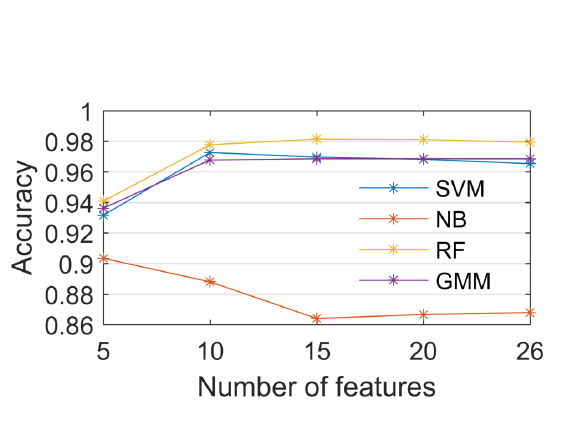
Figure 5. Performance of four classifiers for the silver birch as a function of the different feature sets. Feature sets were deter- mined based on the Fisher filter method described in section 3.2.